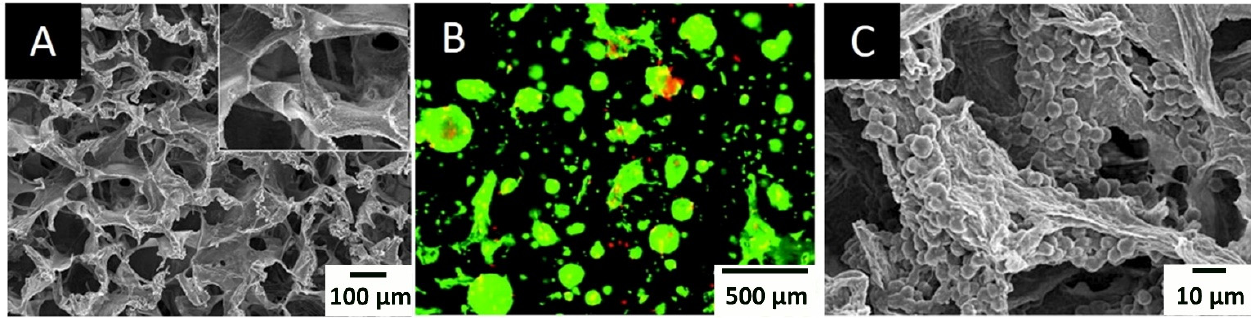
Figure 5. SEM ( A , B ) and fluorescence microscopy image ( B ) of a chitosan–alginate scaffold ( A ) and chondrocyte cells grown on it ( B , C ) [84]. on it ( B , C )